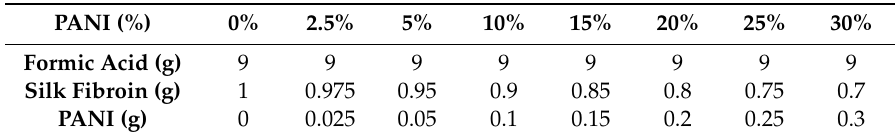
Table 1. Solution compositions for